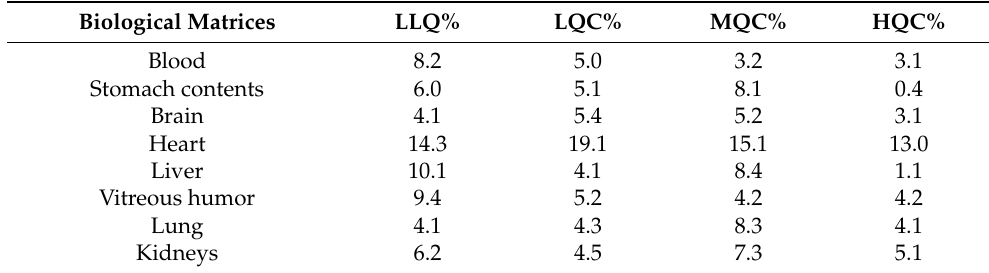
Table 4. Precision in each matrix for aldicarb–sulfoxide was evaluated by means of the coefficient of variation (CV%) of the lower limit of quantification (LLQ), low-quality control (LQC), medium-quality control (MQC), and high-quality control (HQC).